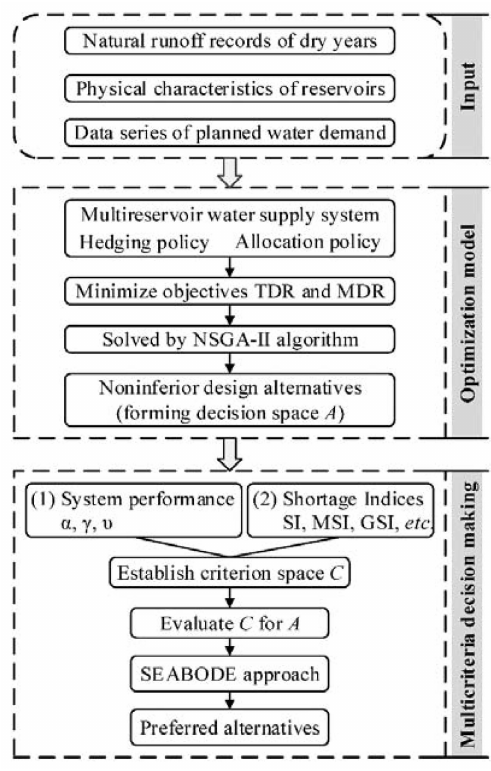
Figure 5. Framework to select preferred operation rules in application.